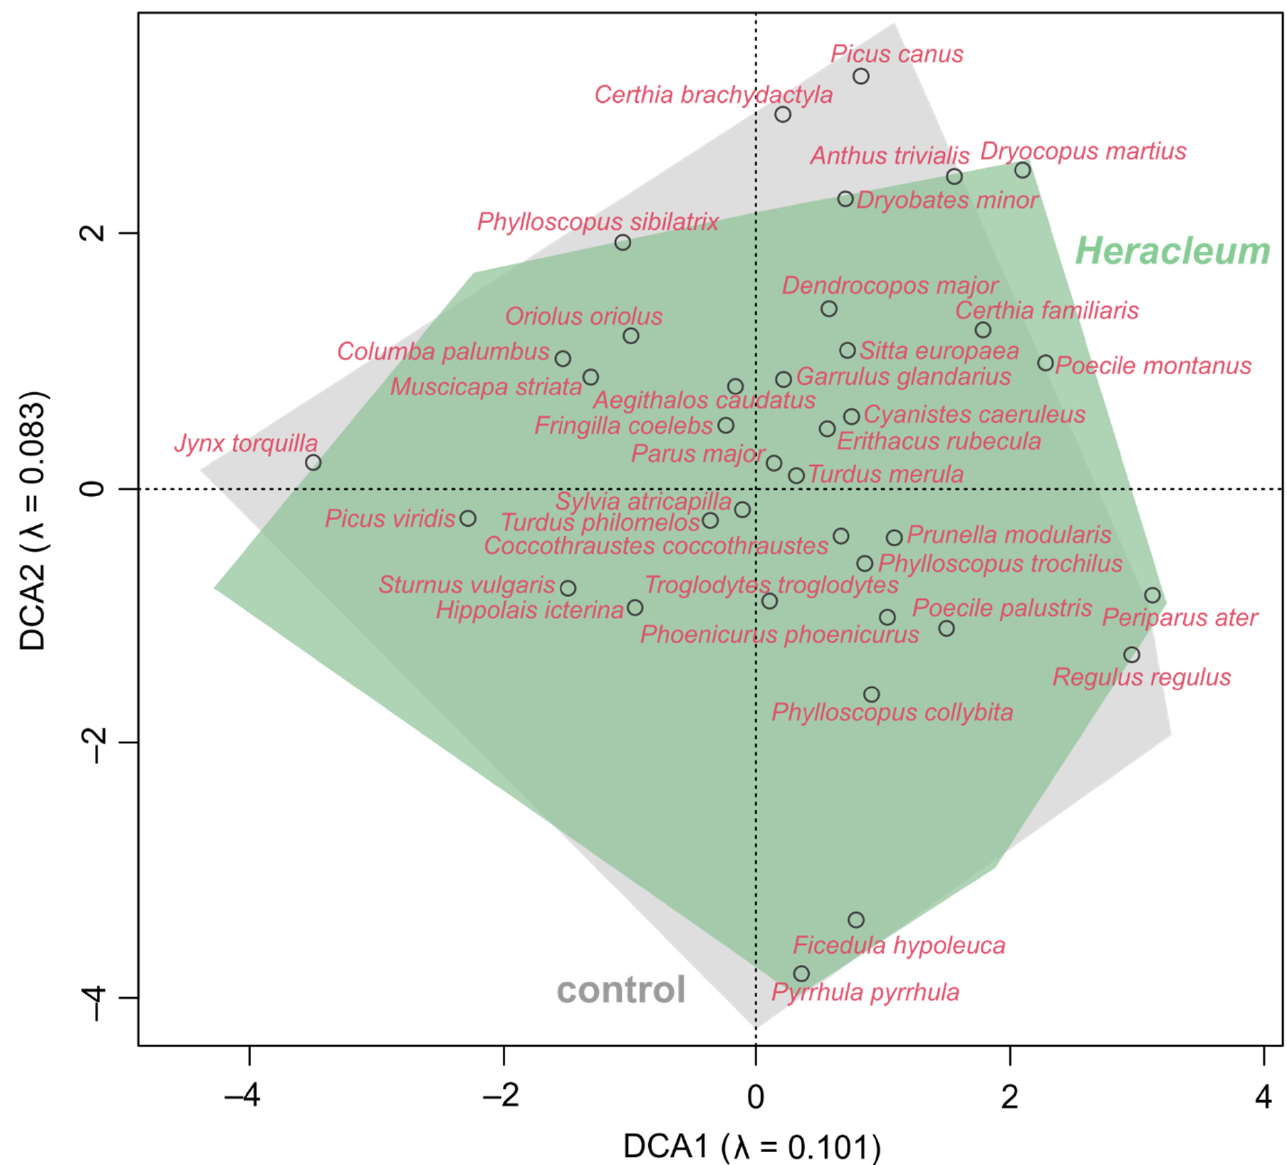
Figure 8. Results of Detrended Correspondence Analysis (DCA) based on forest bird community detected on N = 38 study sites ( λ —eigenvalue). Species matrix was prepared using a natural logarithm; the groups of sites (control, Heracleum ) were expressed by scaled polygons.